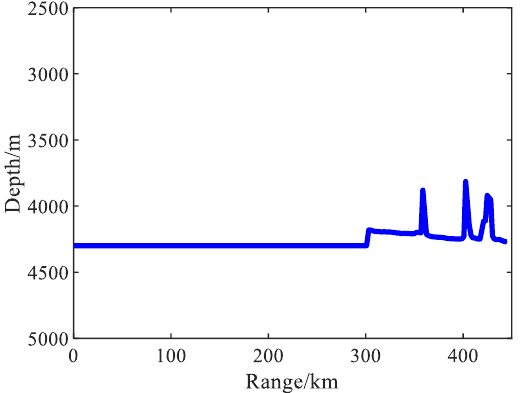
Figure 9. Bathymetry along experimental path.